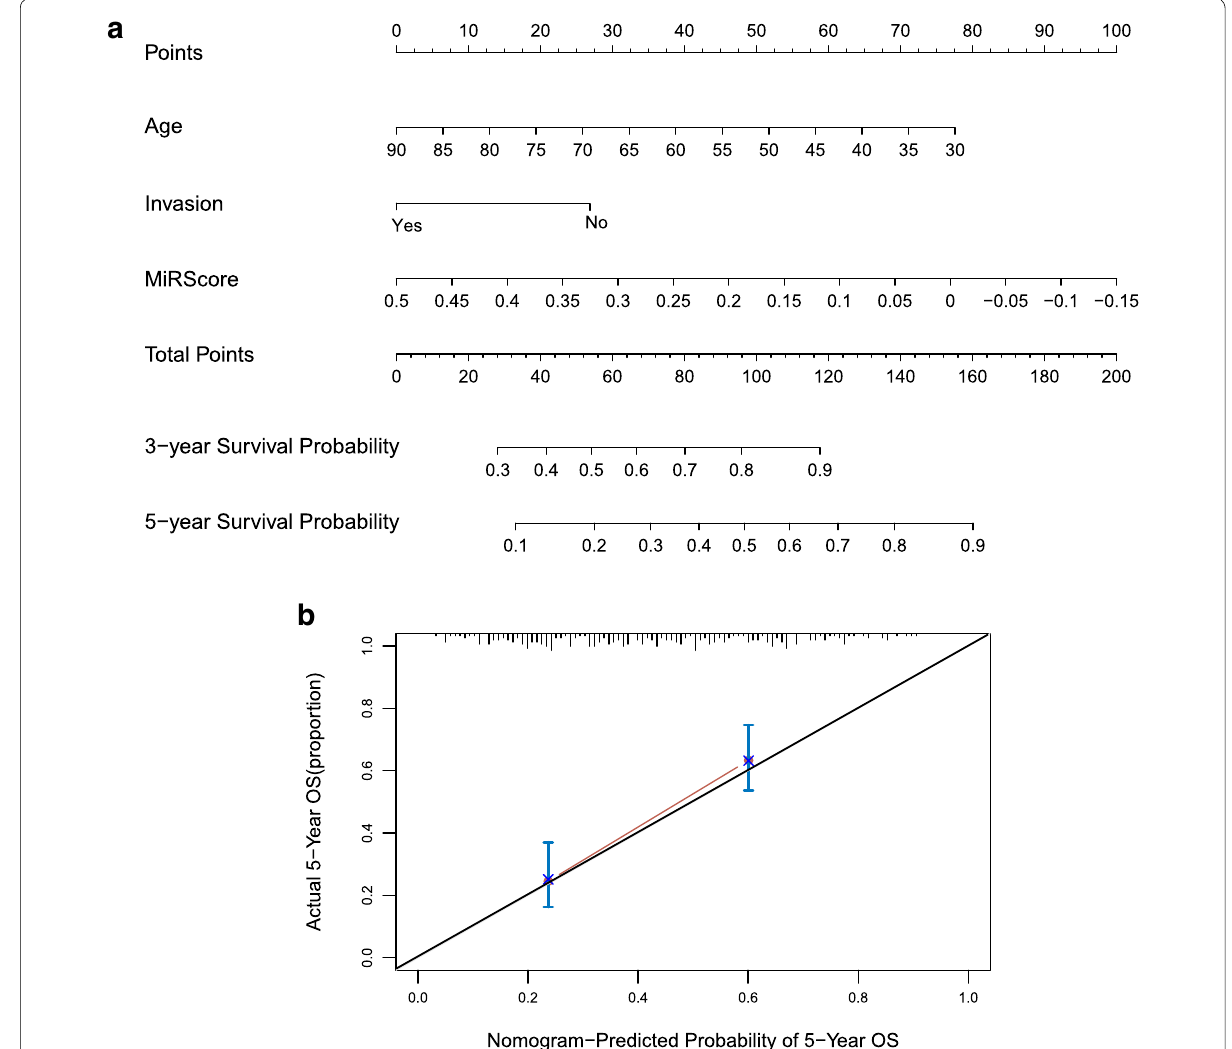
Fig. 4 a The nomogram of 3- and 5-year survival prediction models for these independent prognostic factors. b The nomogram of 5-year survival prediction compliant to actual 5-year